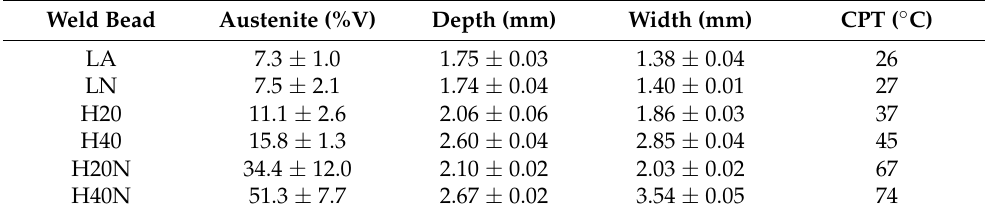
Figure 6. Top view of the weld beads. No visual defects found. Table 4. Weld bead phase balance in percentage of volumetric fraction (%V); geometry obtained, with all values followed by the standard deviation ( ± ); and CPT results.